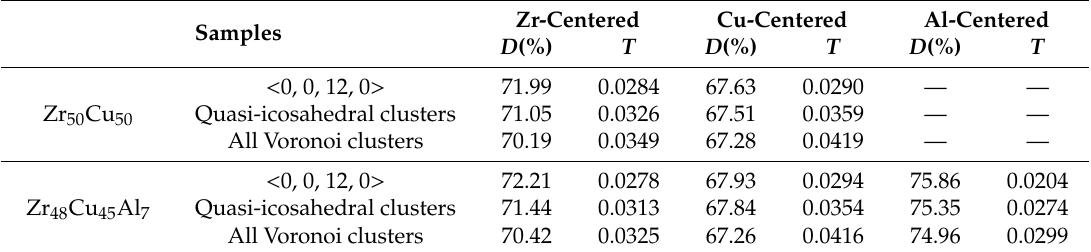
Table 2. Structural information of